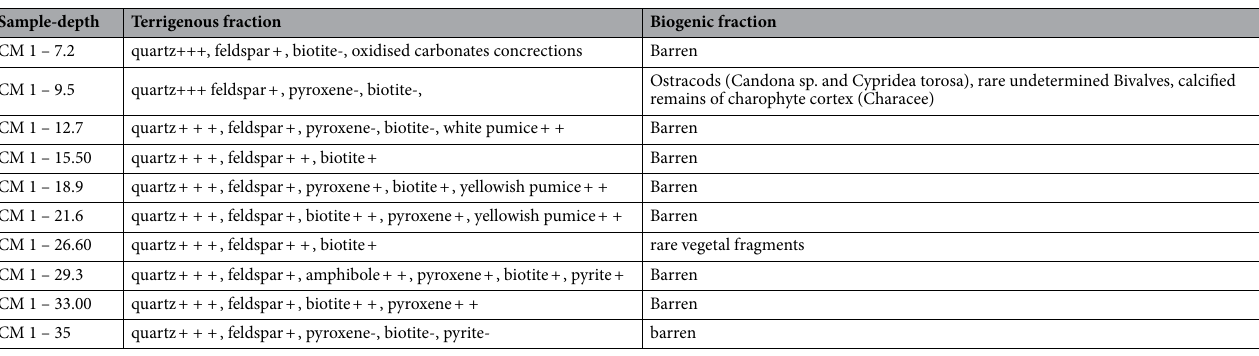
Table 1. Composition of the mineralogical and biogenic fraction > 63 μm in the investigared